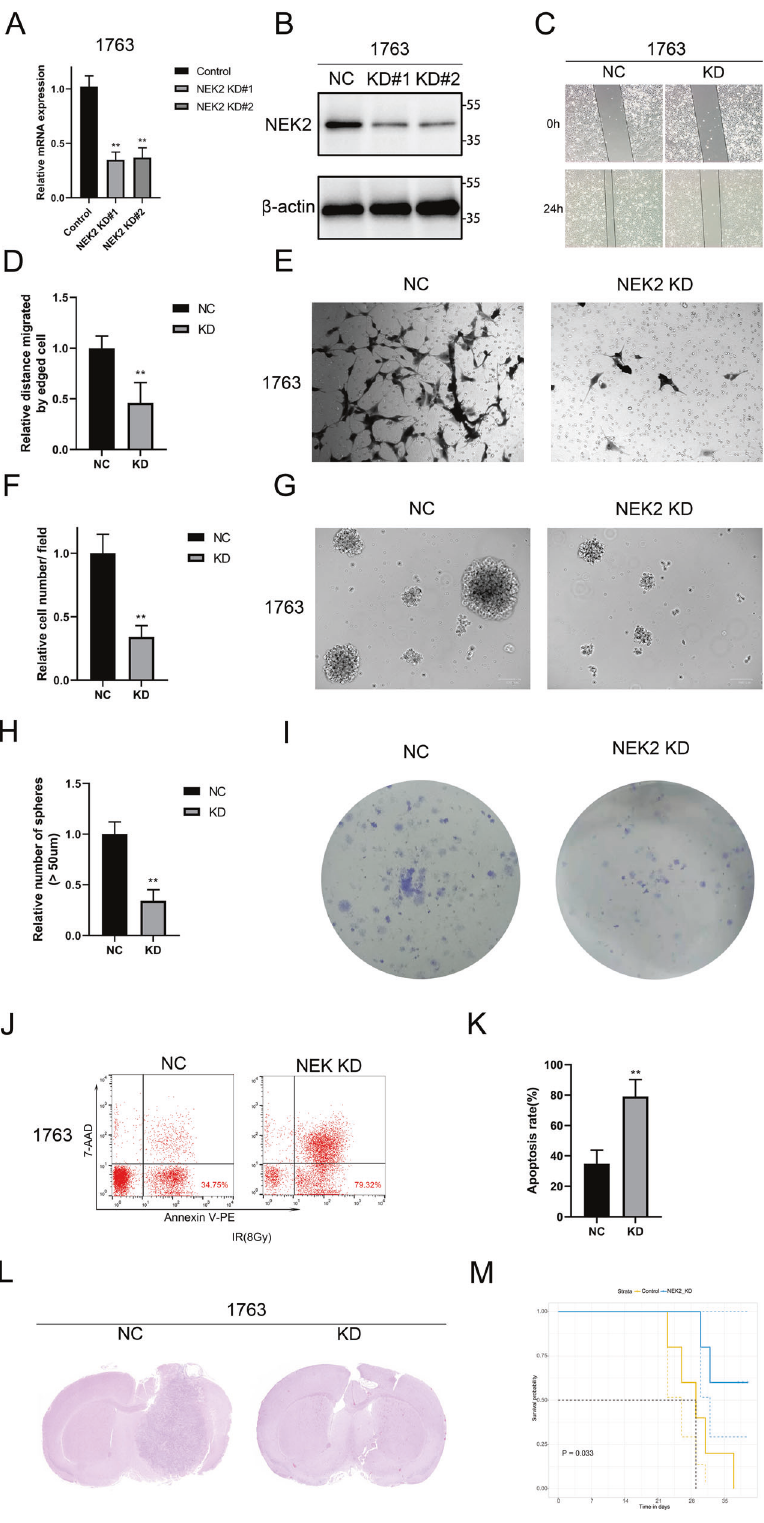
explore the effect of NEK2 knockdown on tumor malignancy in GBM cells. Obviously, the closure time was prolonged and the number of invasive cells was reduced in NEK2 knockdown cells when compared with control cells (Fig. 2C – F). Consistently, we performed sphere formation assays, as is revealed in Fig. 2G, H,